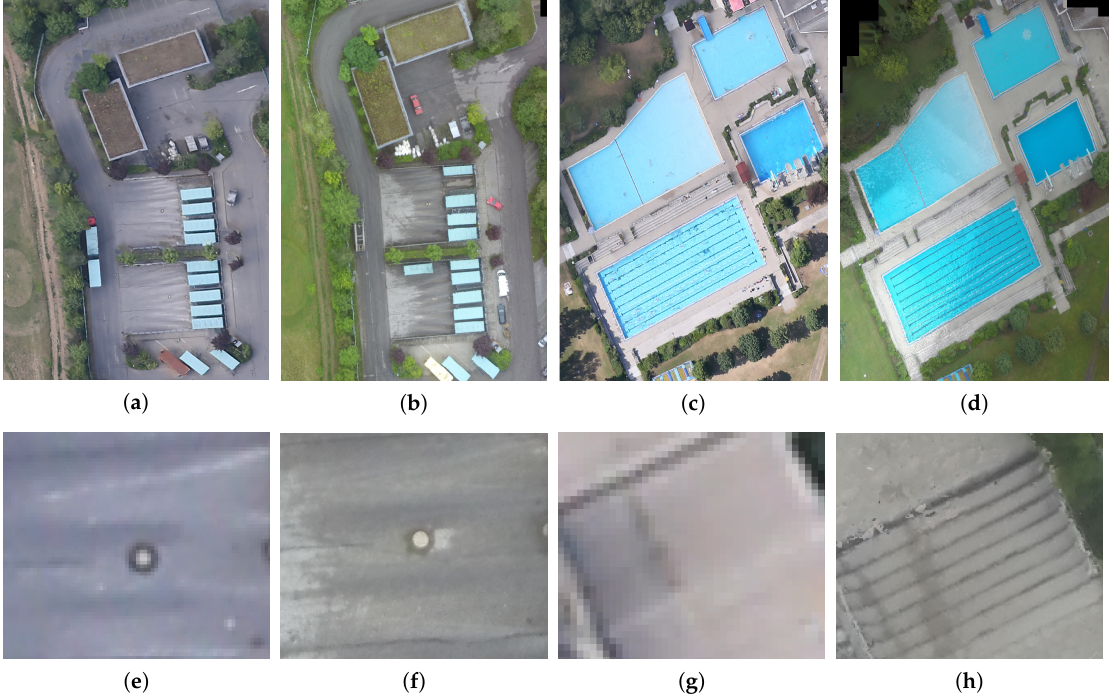
Figure 14. Comparison of ( a , c ) aerial orthophotos with 20-cm GSD and ( b , d ) UAV orthophotos with 2-cm GSD of the Germering dataset; ( e , f ) compare a manhole and ( g , h ) staircases on the aerial and UAV orthophoto,